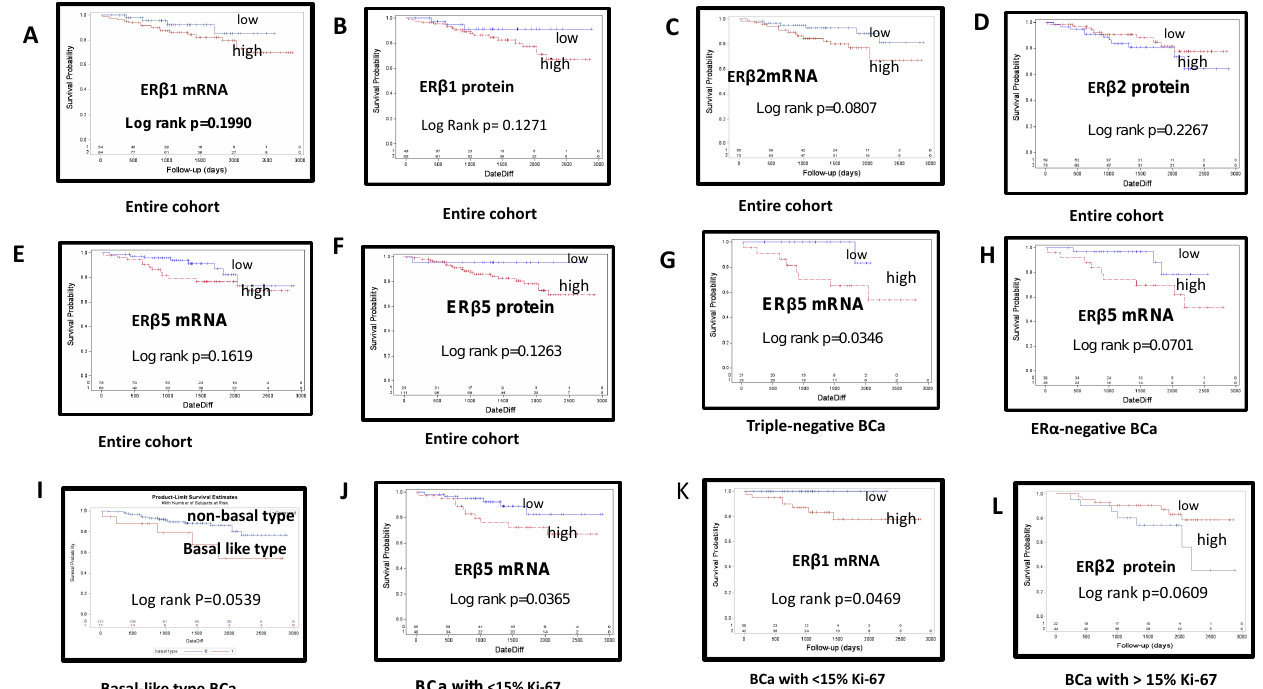
Figure 3. Kaplan–Meier curves of overall survival estimates stratified by estrogen receptor (ER) β mRNA and protein expression in breast cancers: ( A ) high vs. low ER β 1 mRNA in the entire cohort; ( B ) high vs. low ER β 1 protein in the entire cohort; ( C ) high vs. low ER β 2 mRNA in the entire cohort; ( D ) high vs. low ER β 2 protein in the entire cohort; ( E ) high vs. low ER β 5 protein in the entire cohort; ( F ) high vs. low ER β 5 protein in the entire cohort; ( G ) high vs. low ER β 5 mRNA expression in patients with triple-negative breast cancer; ( H ) high vs. low ER β 5 mRNA expression in ER α -negative BCa; ( I ) basal-like type BCa with trend of poor OS; ( J ) high or low ER β 5 mRNA expression in BCa with <15% Ki-67 staining; ( K ) high vs. low ER β 1 mRNA expression in BCa exhibiting <15% Ki-67 staining; ( L ) high or low ER β 2 protein expression in BCa exhibiting >15% Ki-67.